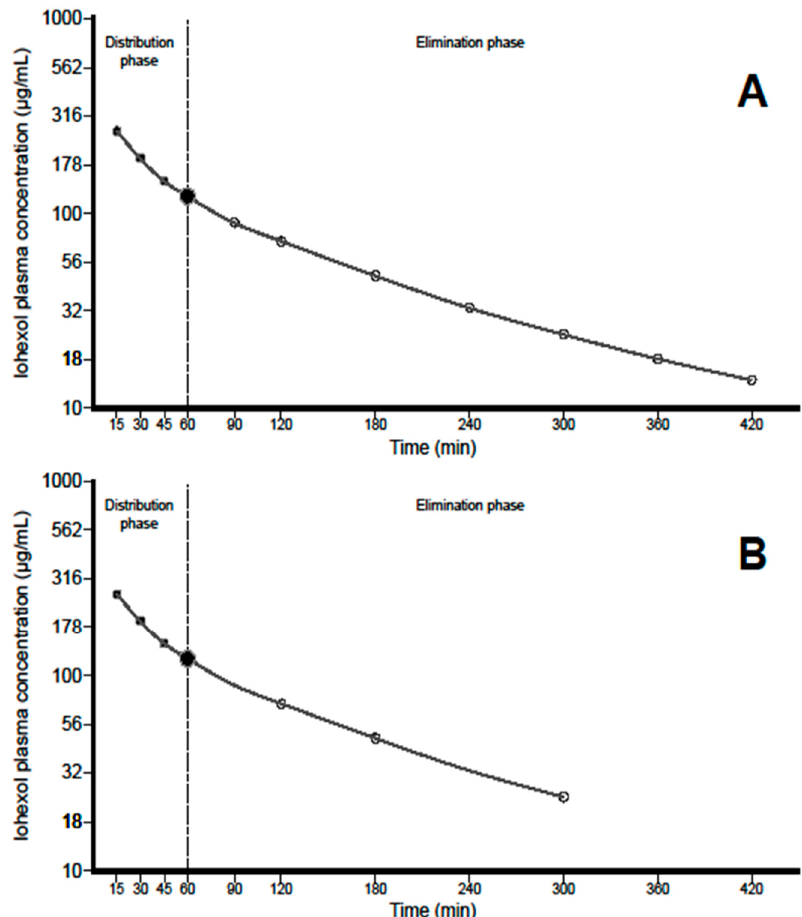
Figure 2. Pharmacokinetic models of the plasma clearance of iohexol in sheep. ( A ) Two-compartment model (CL2): includes sampling points of the distribution phase at 15, 30 and 45 min (black circles), the point at 60 min and those of the elimination phase at 90, 120, 180, 240, 300, 360 and 420 min (white circles). The one-compartment model, either with (CL1 f ) or without a formula (CL1), considers only points obtained from 60 min onwards. ( B ) Simplified method (SM): a two-compartment model using seven samples from both the distribution and elimination phases (15, 30, 45, 60, 120, 180 and 300 min).